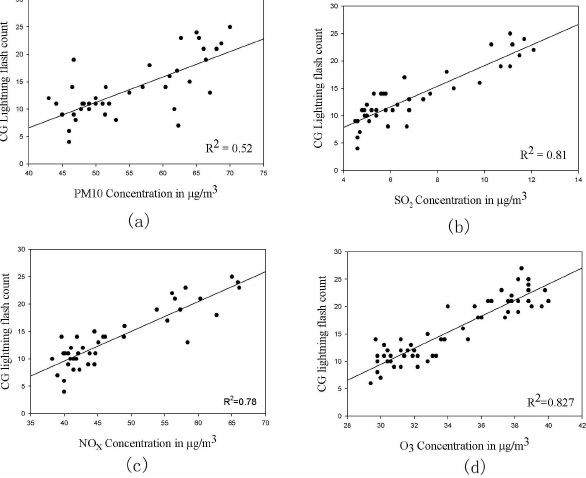
Figure 5. Scatterplot of PM 10 , SO 2 , NO x and O 3 concentrations versus CG lightning flash count during premonsoon months for the whole studied period (2005 to 2010).